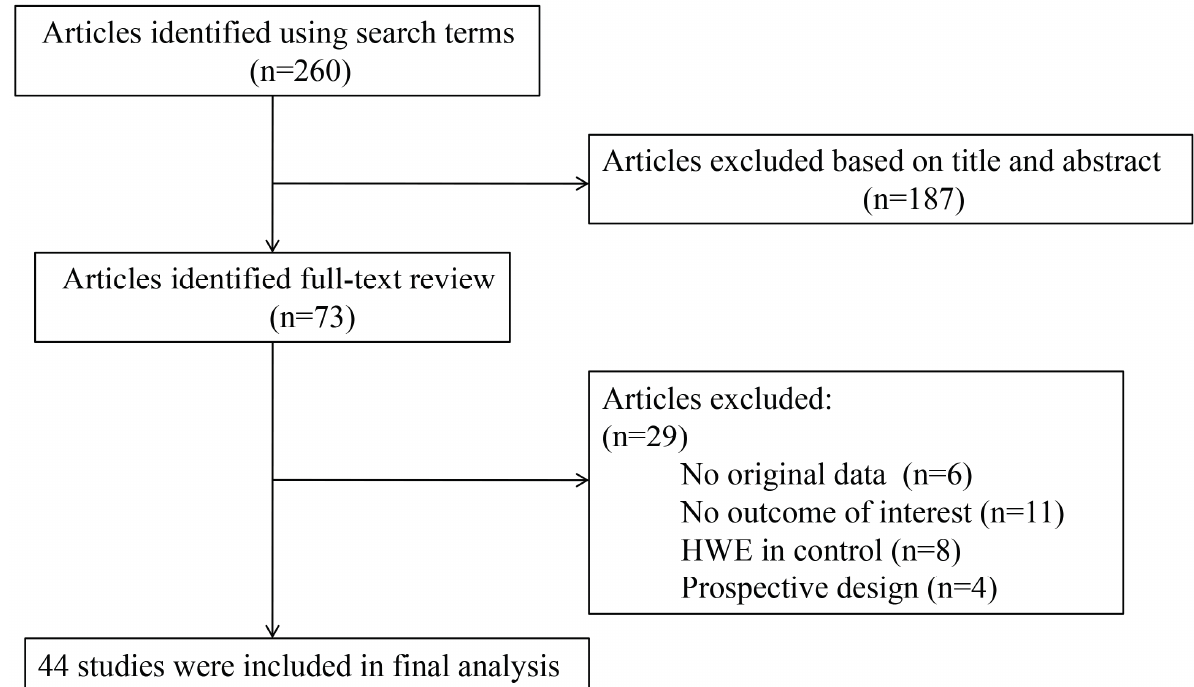
Figure 1. Study flow